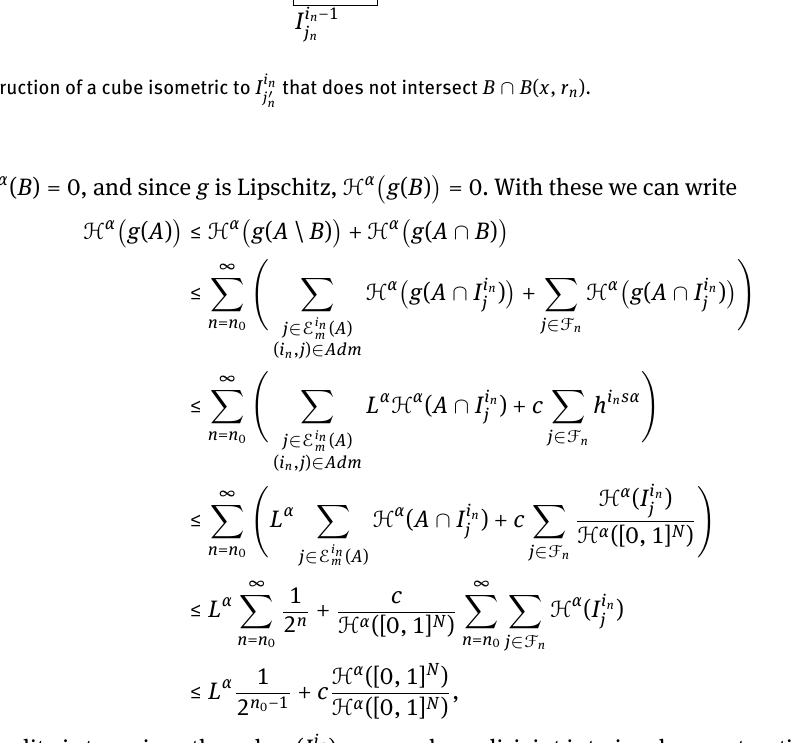
Figure 5: Construction of a cube isometric to I i n